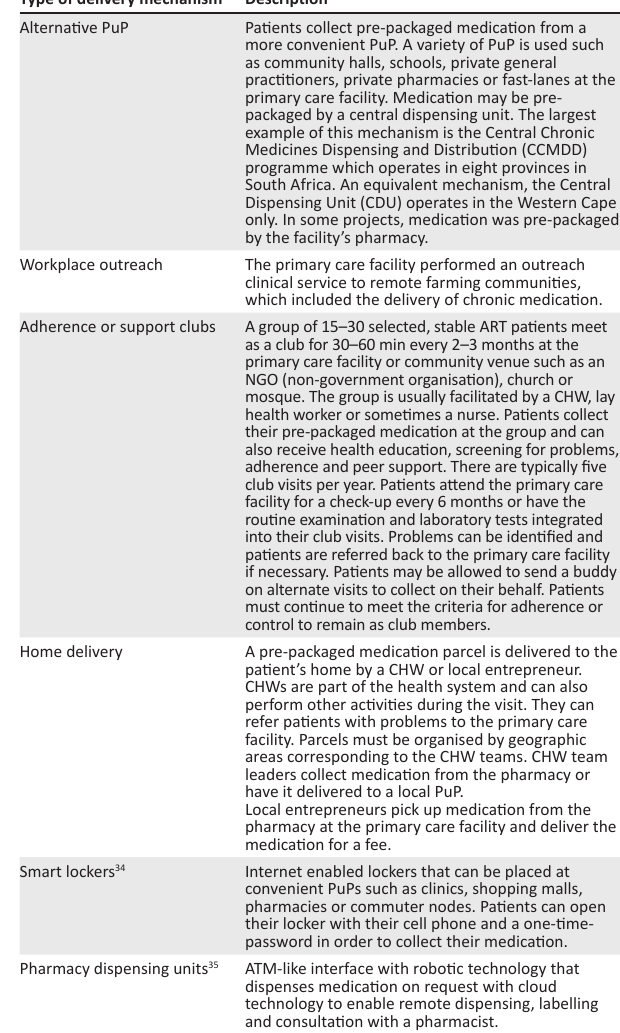
TABLE 3: Description of alternative delivery mechanisms. TABLE 2: Characteristics of included articles ( N = 26).